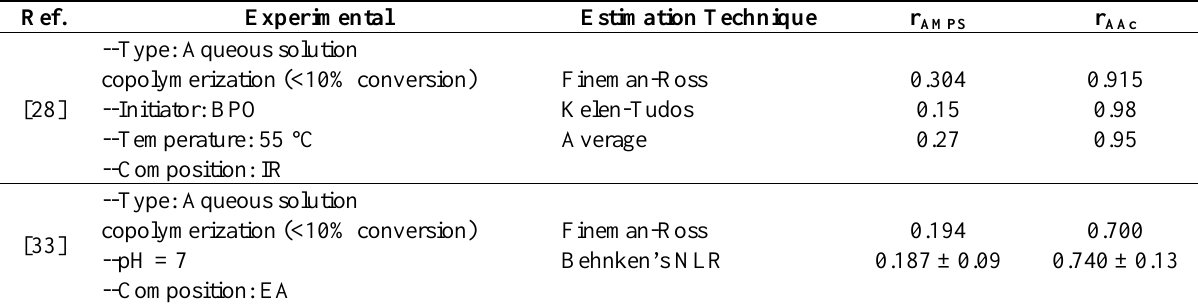
Table 3. Reactivity ratio estimates for AMPS/AAc